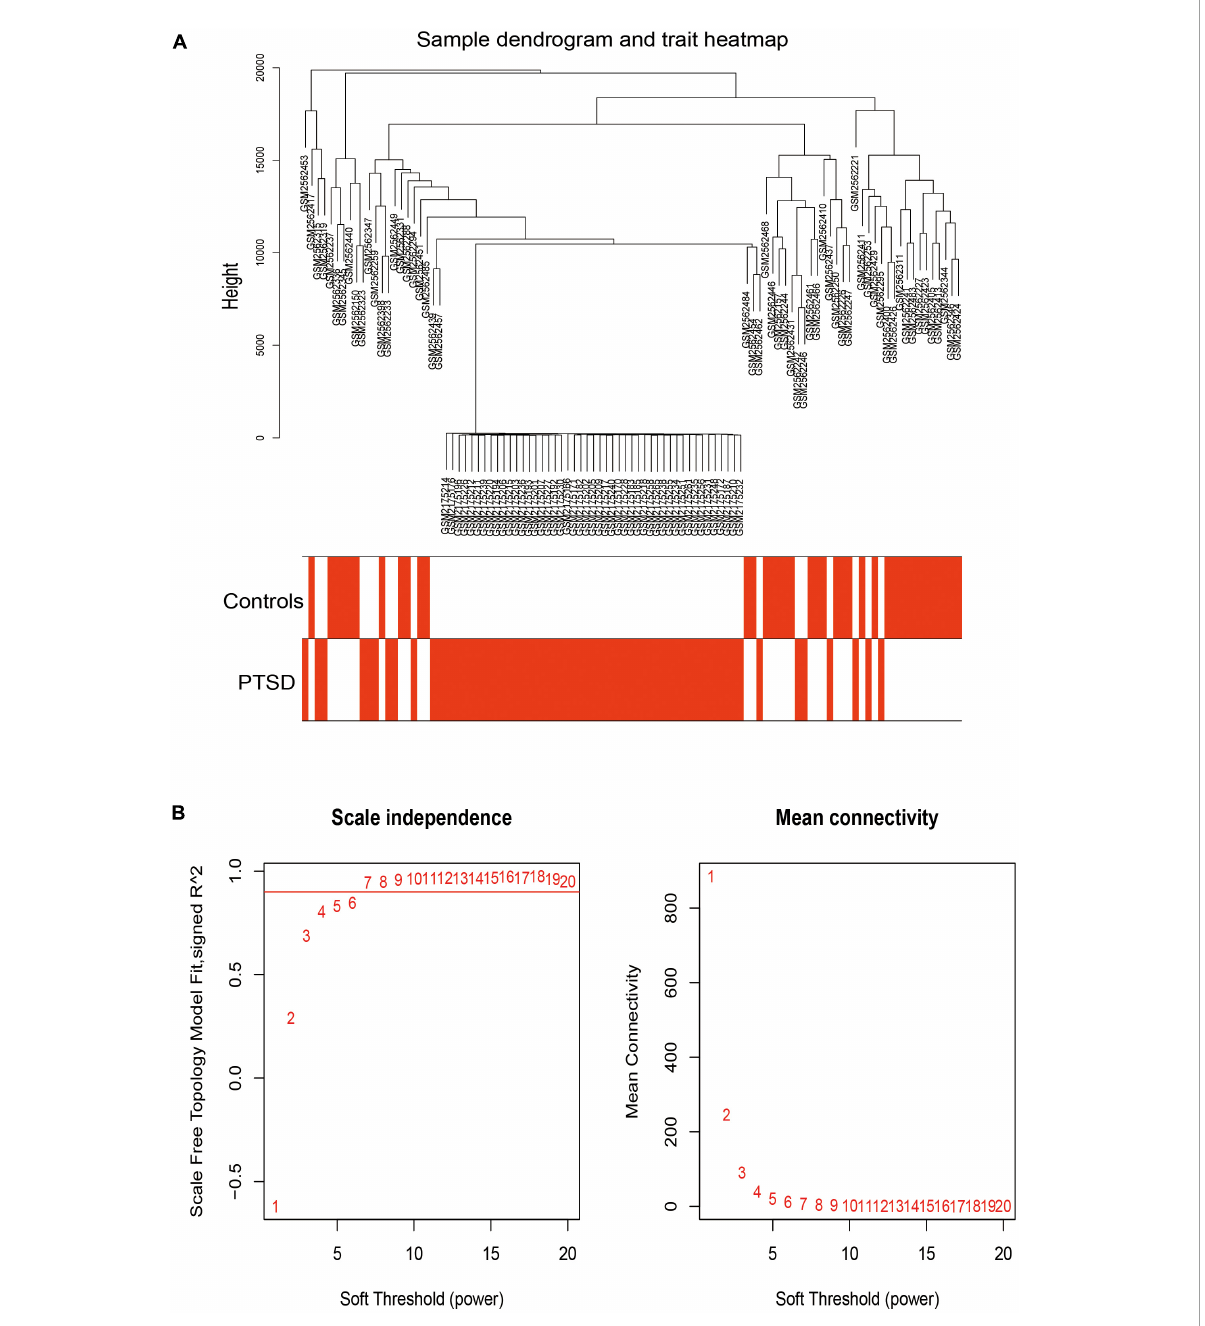
FIGURE6 (A) The gene hierarchy clustering plots showed that all samples were divided into two clusters (in the red and white plot) with the WGCNA algorithm method. (B) A scale-free network distribution was with stable average connectivity when the soft threshold power β was set to 7.